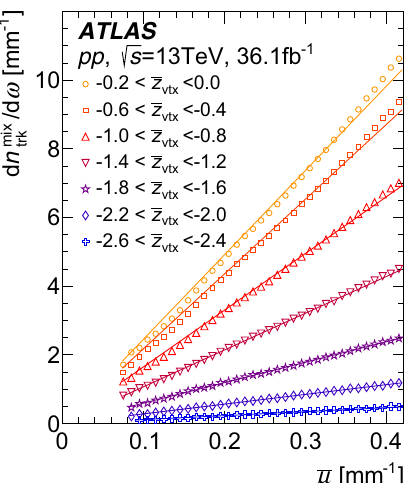
Fig. 2 The number of tracks per mm as a function of ω , defined by Eq. (2), for Direct (solid markers) and Mixed events (open markers). The three panels show results in different intervals of the reduced vertex ¯ z vtx position and different marker colours correspond to several inter- vals of reduced ¯ μ . The solid lines are parabolic fits to Mixed events in